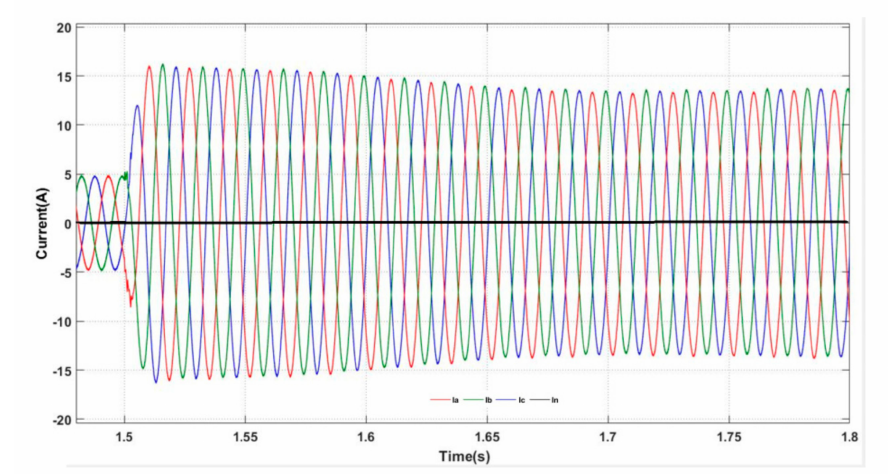
Figure 24. Experimental result of the sliding DFT for case